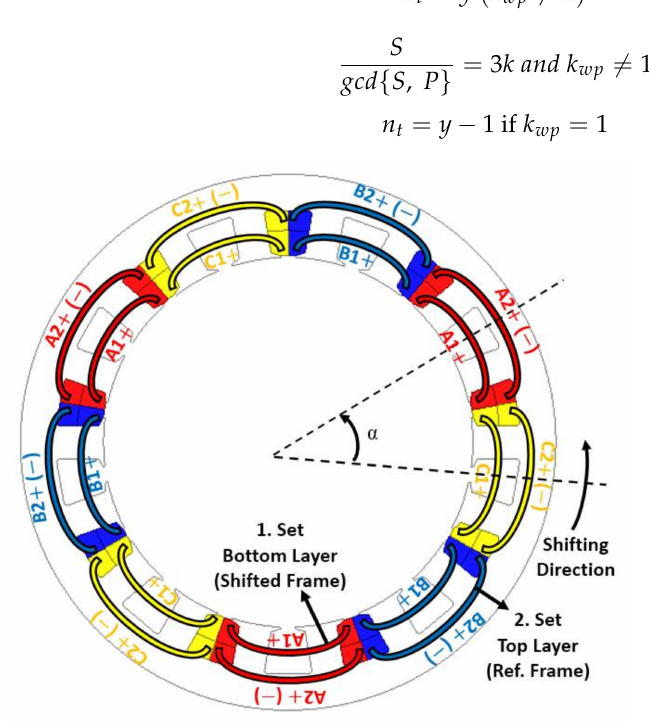
Figure 5. Winding layout of 2x9S/6P-4L combination. Once the winding directions are ( + , + ), variation of the winding harmonic factors with α is shown in Figure 6. It is deduced that compared to the 9S/6P, adding auxiliary teeth leads further reduction of the winding harmonics. Depending on α , some of the low- and high-order harmonics have been reduced and some have completely been eliminated i.e., 6th, 30th, 42nd, 63rd, and so on harmonics are cancelled at the 180 ◦ e. But, the funda- mental winding factor has decreased at this shift angle. Once the winding directions are ( + , − ), the variation of the winding harmonic factors with shift angle is shown in Figure 7. By adopting the negative polarity of the 2nd set of windings, the 6th and all the multiples of the 6th harmonics are eliminated at 180 ◦ e. In addition, the fundamental winding factor is maximized at 180 ◦ e and hence the optimum shifting angle is found as 180 ◦ e for 2x9S/6P combination. After shifting 180 ◦ e (3 slot-pitches) of the 2nd winding set and assigning the correct polarizations, the final winding arrangement of the 2x9S/6P is illustrated in Figure